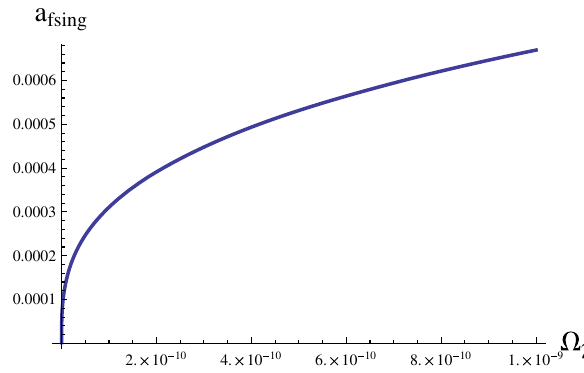
Fig. 11 Diagram of the relation between a sing and positive (cid:3) γ . Note that in the limit (cid:3) γ (cid:7)→ 0 the singularity overlaps with a big-bang singularity